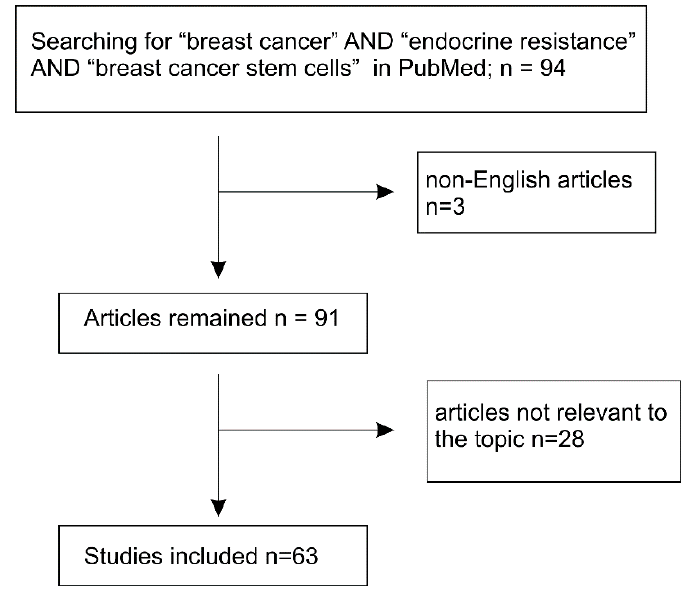
Figure 1. Systemic literature searching conditions and selection of articles for review.